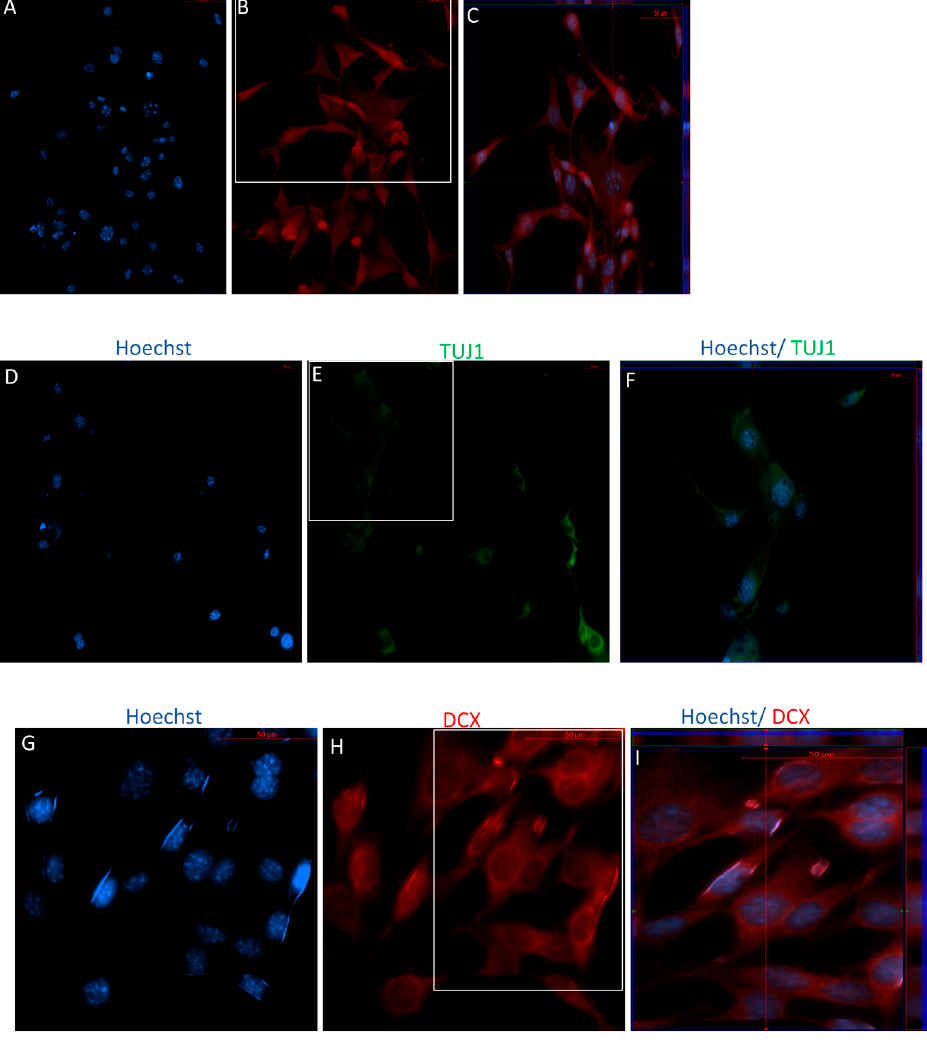
Figure 6. Immunocytochemistry/immunofluorescence (ICC/IF) performed on P4 following Stage One of the IDI. Following exposure to bFGF and EGF, cells revealed positive staining of the immature neuronal markers in P4 cells, including Nestin (( B ) red), TUJ1 (( E ) green), and DCX (( H ) red). Hoechst-labeled P4 NSCs ( A , D , G ). Orthogonal displays of z -stack are represented in merged images ( C , F , I ).